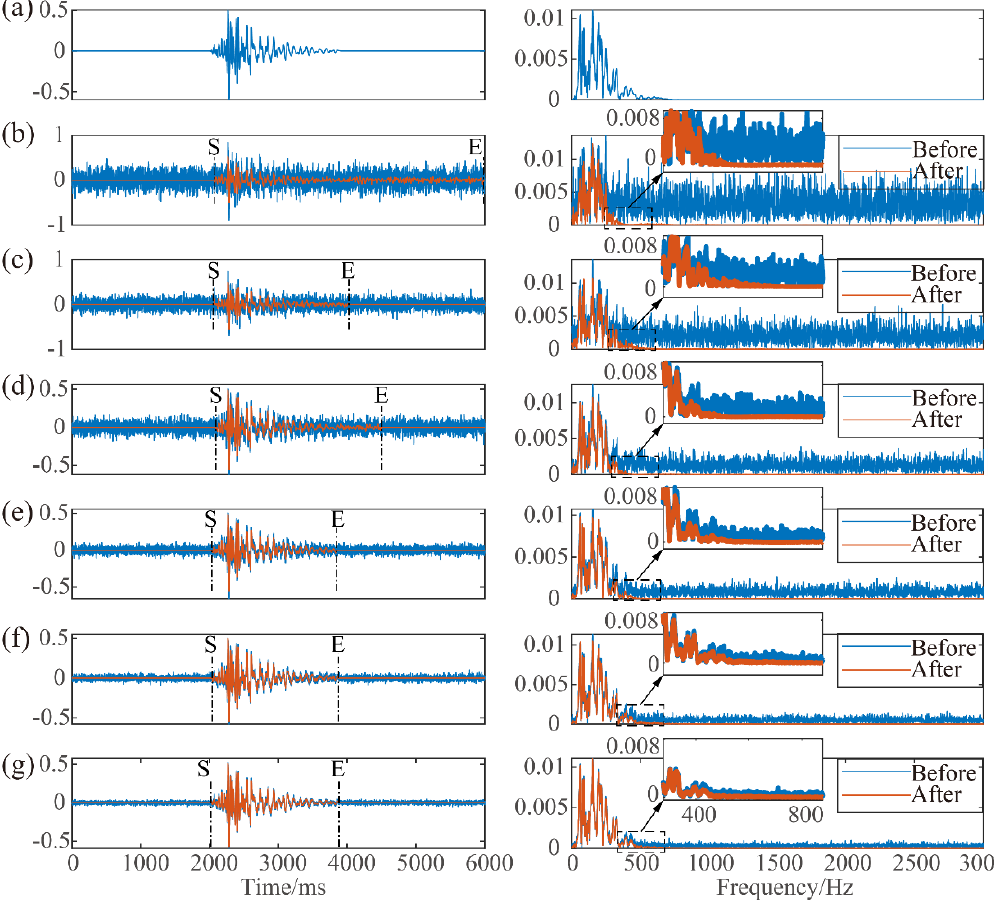
Figure 8. Waveforms and spectrograms of noisy signals with different SNR s before and after noise attenuation by VMD-AIC. ( a ) The original noiseless MS signal; ( b ) noisy signal with SNR = − 8; ( c ) noisy signal with SNR = − 4; ( d ) noisy signal with SNR = 0; ( e ) noisy signal with SNR = 4; ( f ) noisy signal with SNR = 8; ( g ) noisy signal with SNR = 10. The red line in the figure represents the signal after denoising by VMD-AIC, and the blue line represents the waveform before noise reduction.